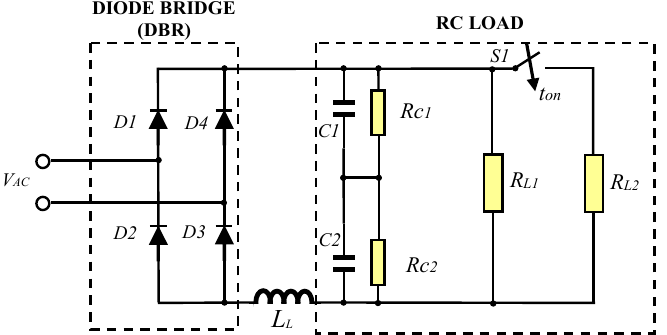
Figure 2. Diode-bridge rectifier nonlinear load supplying a resistive-capacitive load. Table 1. Main parameters of VSI and Z NL